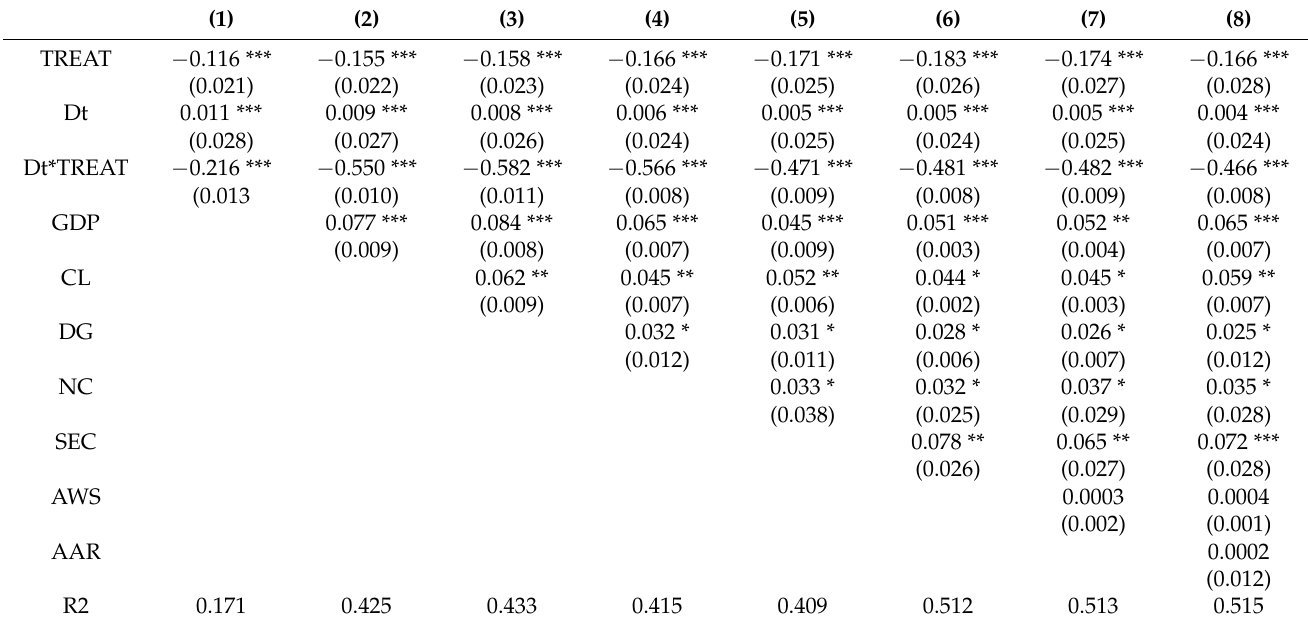
Table 3. Estimation results of PSM-DID